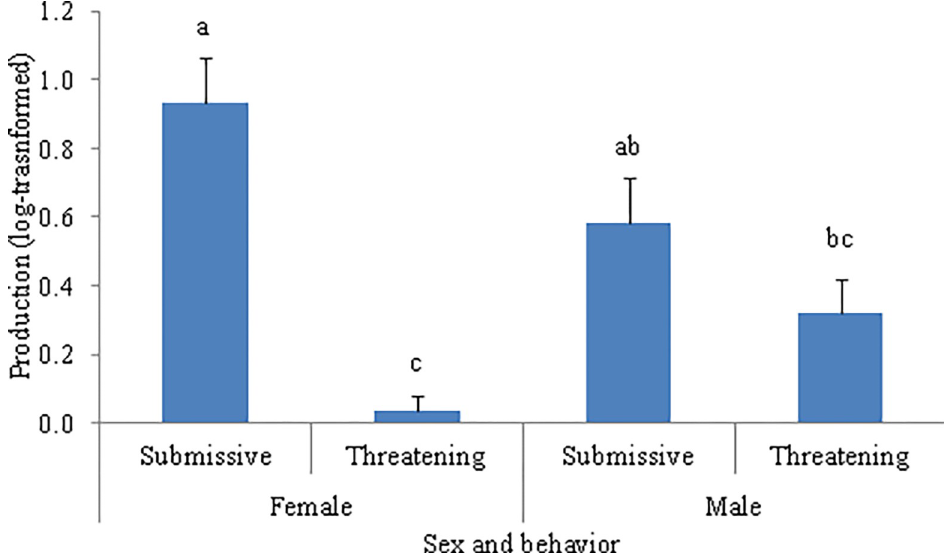
Fig 5. Mean (log-transformed) production of unimodal signals by white-lipped peccaries (N = 21). The female and male white-lipped peccaries could be displaying either threatening or submissive behaviors. Error bars denote SE of means. Different letters above bars represent a significant difference ( P <